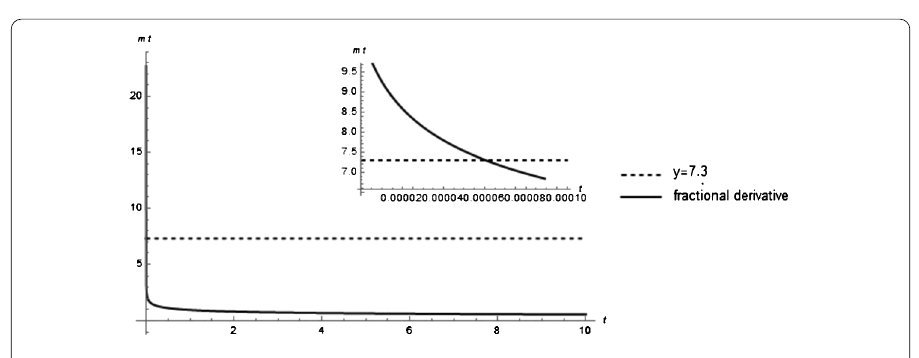
Dq RL t ( m ( t )) 0 m ( t